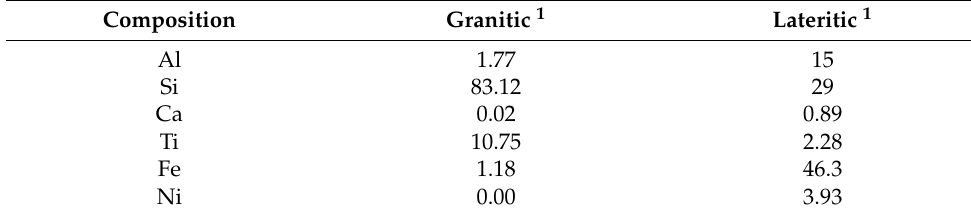
Table 2. Chemical composition of